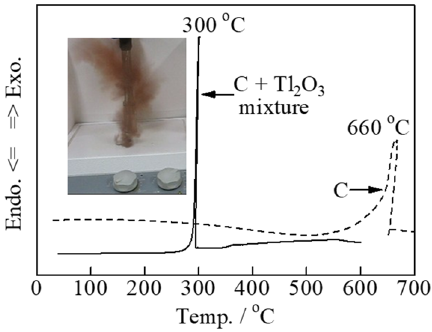
Figure 1. DSC curves of carbon black (5 wt%) mixed with a pure Tl 2 O 3 catalyst. Inset is a digital photograph of explosive carbon combustion.